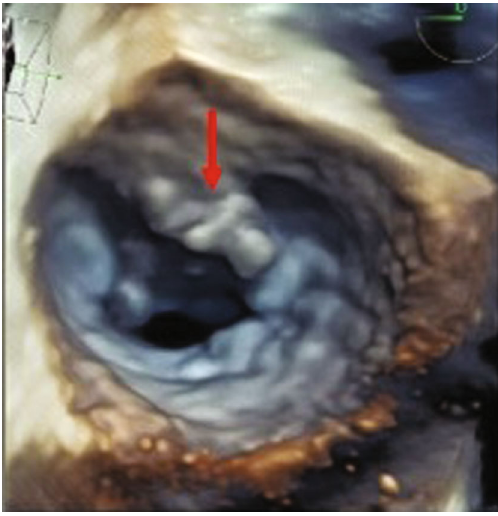
Figure 4: Intraoperative view of TAVR showing thickened TAVR lea fl ets (red arrow) and vegetative material (yellow